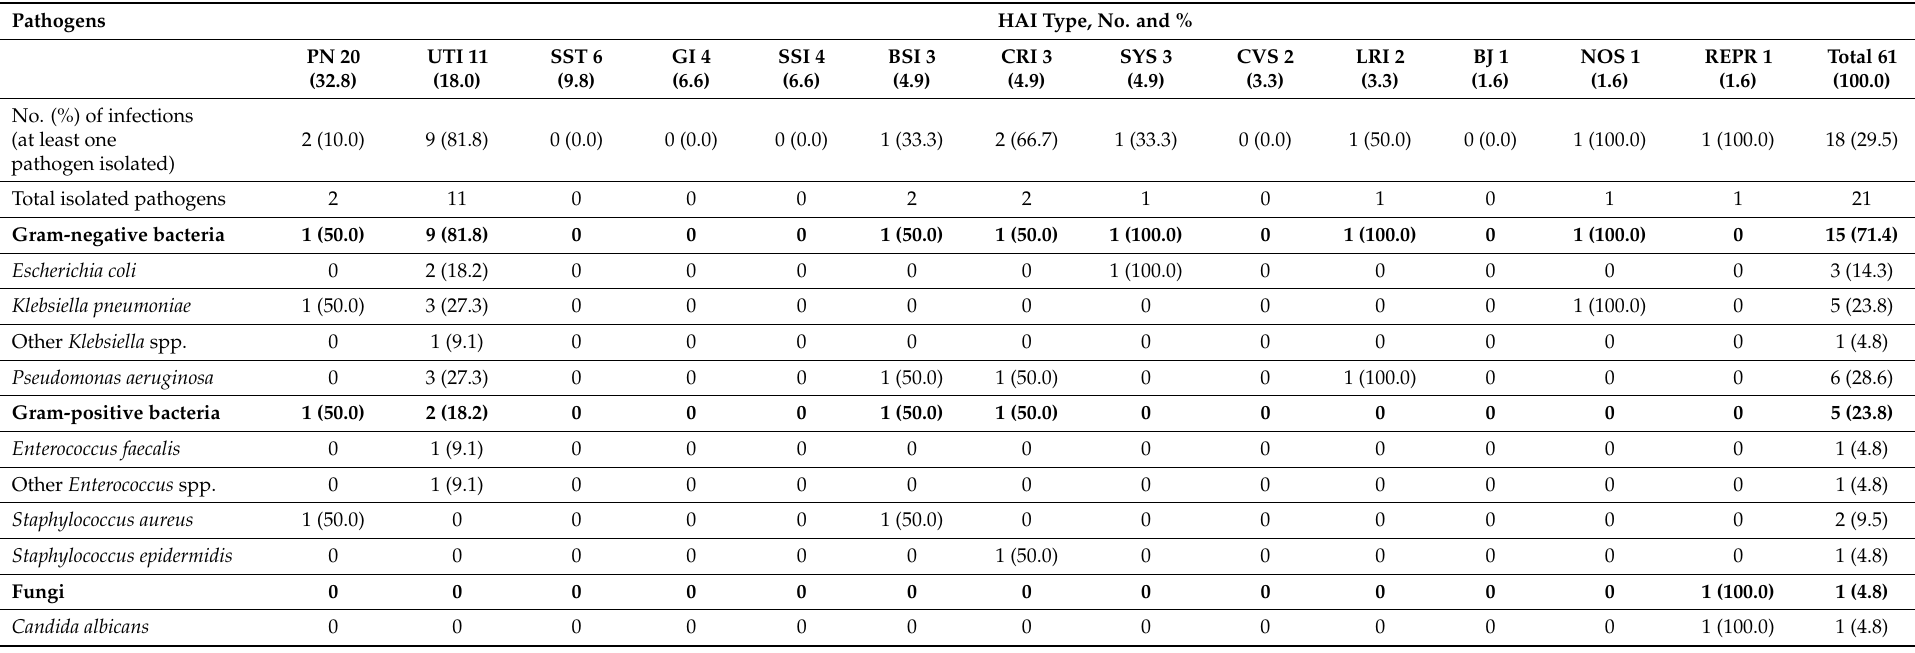
Table 2. Pathogens causing healthcare-associated